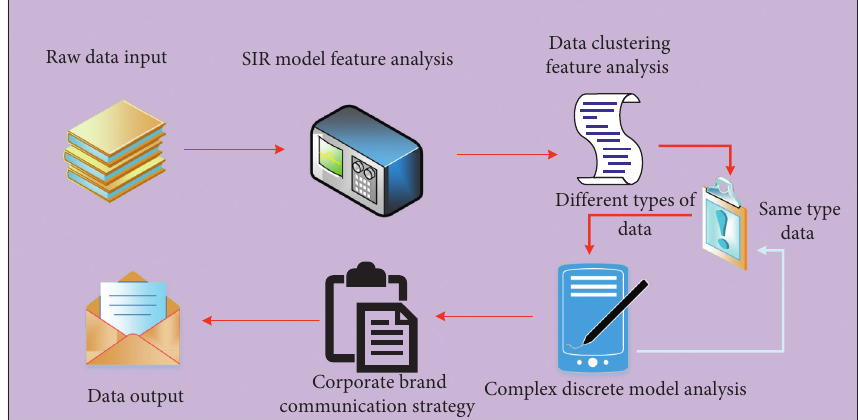
Figure 2: The basic network framework of the trinity analysis network based on the SIR model.